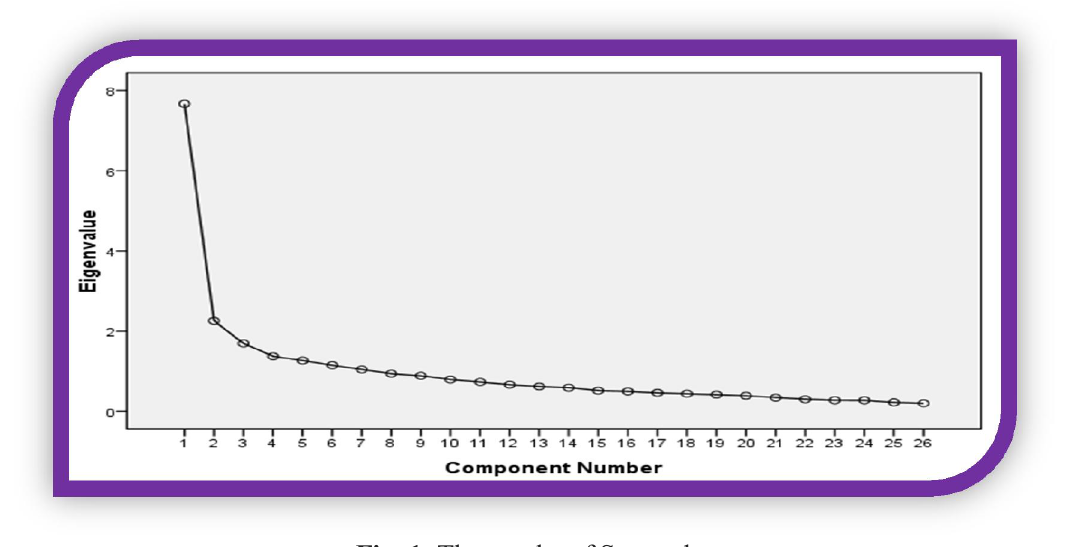
Fig. 1. The results of Scree plot The results of total variance explained Initial